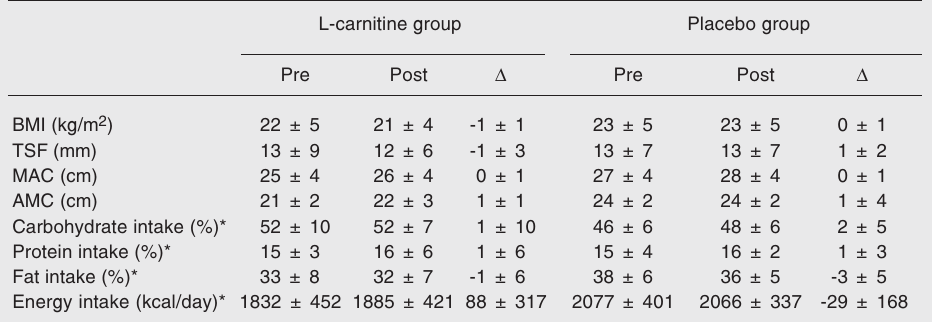
Data are reported as mean ± SD for 8 patients in each group. There were no significant differences between the L-carnitine and placebo groups. BMI = body mass index; TSF = triceps skinfold; MAC = midarm circumference; AMC = arm muscle circumference; ∆ = absolute delta comparison (post-treatment minus pretreatment values). *Estimated from information provided by the